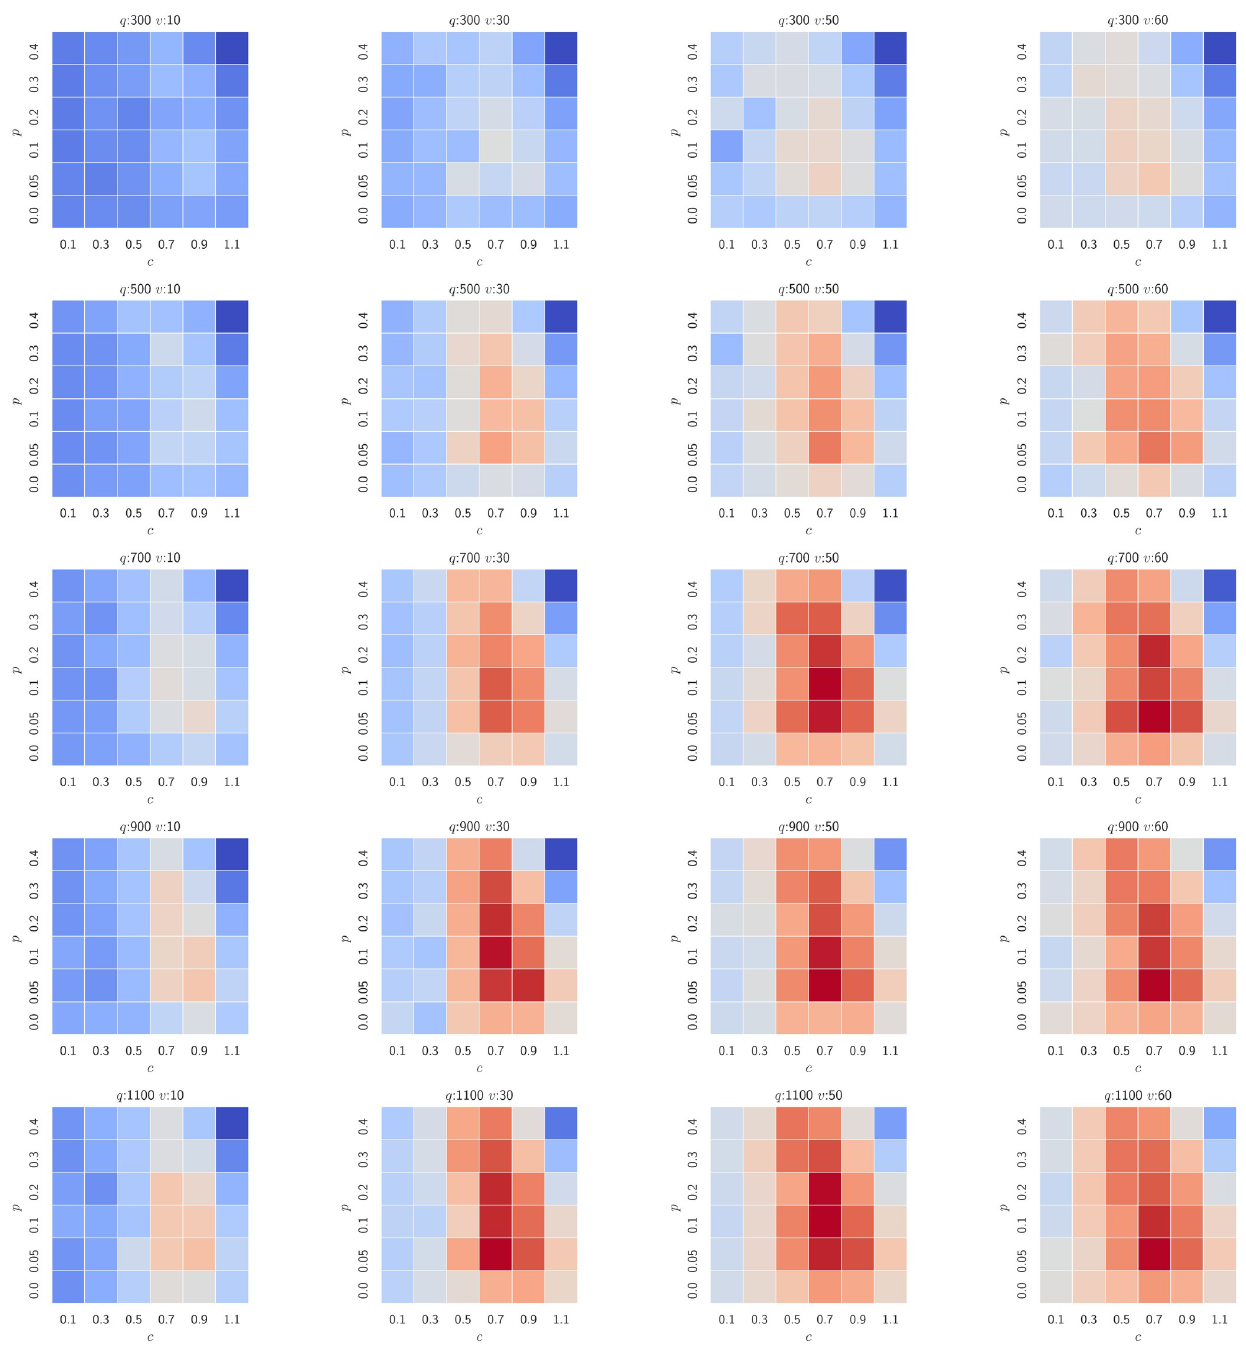
Fig 11. The total commission collected by the platform in the series of over 1000 experiments (blue cells denote deficit, red ones denote profit). Each grid denotes a single supply-demand setting with a fixed number of trip requests ( q ) and a fixed number of potential drivers ( v ). Every single cell therein represents a stable state of the evolution process depicted in Fig 10. The platform explores the best setting of a ride-pooling discount ( p —rows) and a share of fares remaining with a driver ( c —columns) to maximise its profit. For a low demand the system is not profitable (top left), yet as the number of drivers increases, the platform starts generating profits (top right). As both supply and demand increase, the central parts of the grids become profitable, i.e. commissions between 0.5 and 0.7. Notably, a too low commission for drivers ( < 0.5) is not profitable for the platform, as it leads to fewer participating drivers and thus lower revenues, and so does a too high commission for drivers (when drivers stay within the system but the platform does not generate profit). At the high supply and demand levels, the platform may start providing pooled rides as it remains profitable even for high discounts offered ( p > 0.2). Nonetheless, under this setting the platform profit is always maximised at low discounts ( p = 0.05) and introducing lower prices for pooling would result in lower profits.